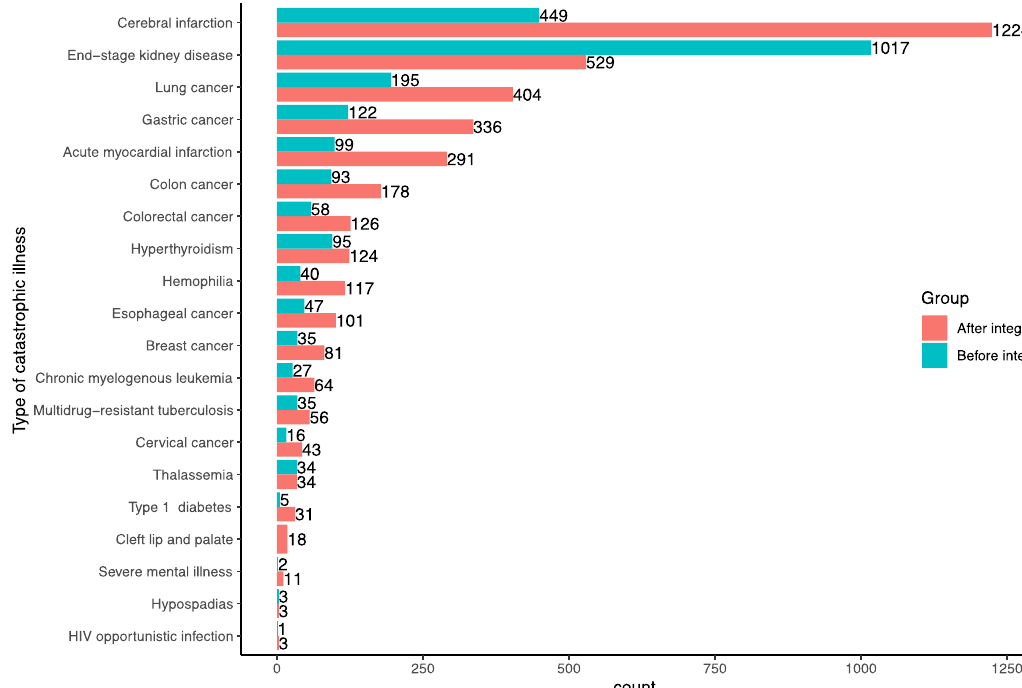
Figure 1. Comparison of catastrophic illnesses before and after the integration in the sampled hospital from 2014 to